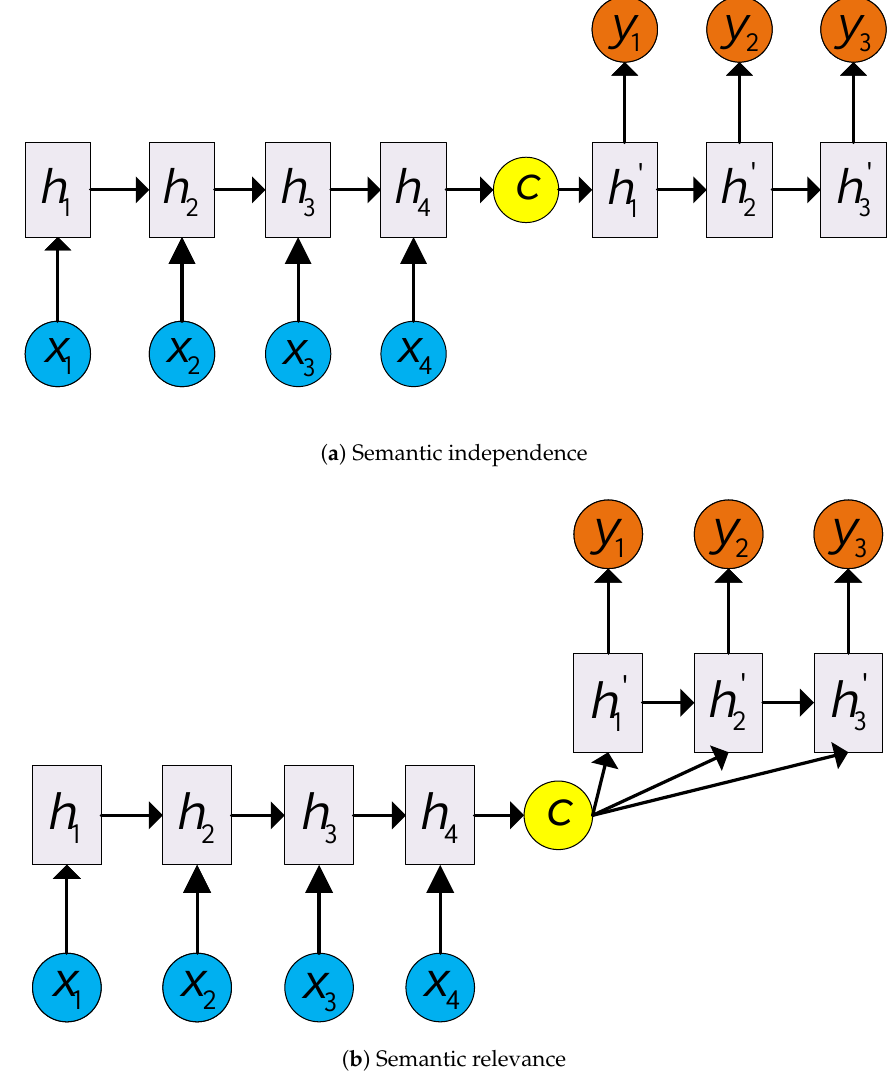
Figure 1. Typical Seq2seq